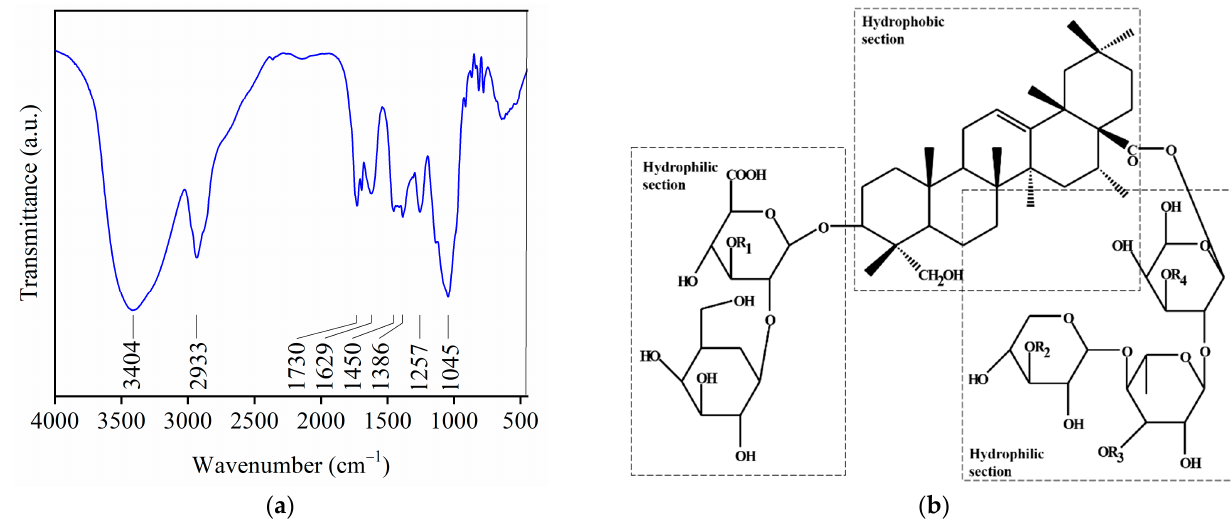
Figure 1. ( a ) FTIR spectrum of the soap-nut extract and ( b ) saponin